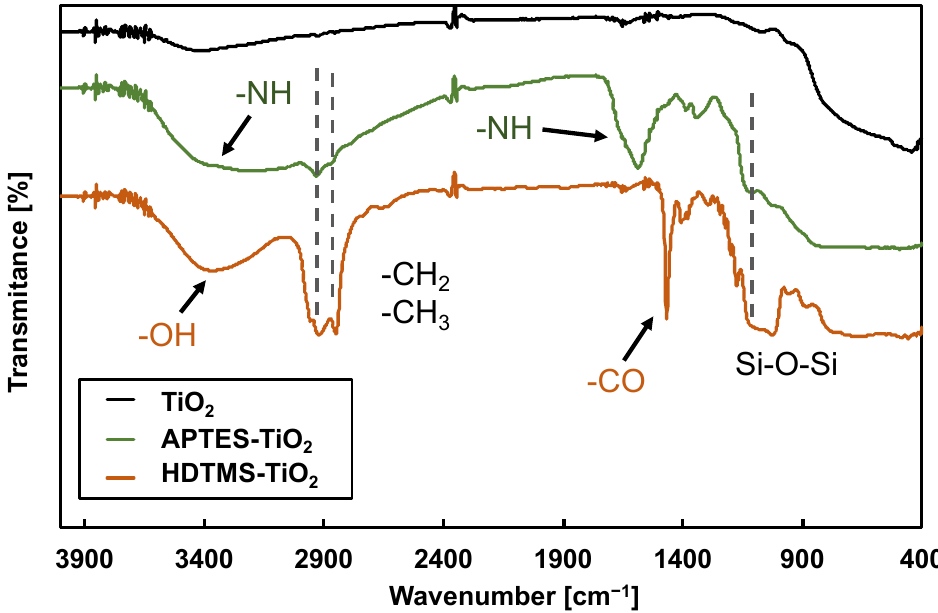
Figure 1. FTIR spectra of TiO 2 , APTES-TiO 2 , and HDTMS-TiO 2 particles.